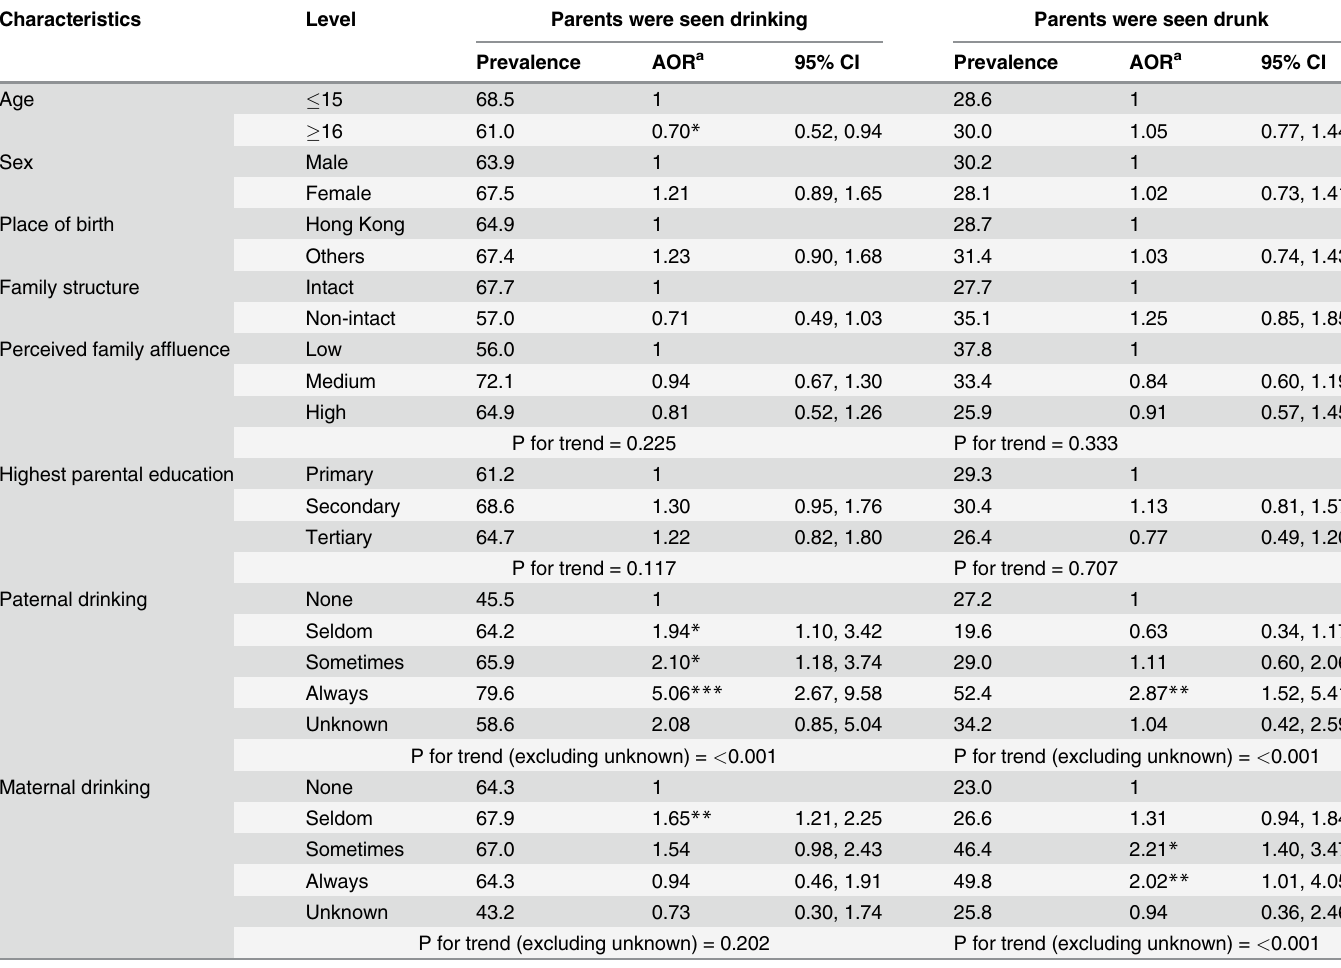
Table 2. Prevalence and adjusted odds ratios (AORs) for parents being seen drinking and drunk.